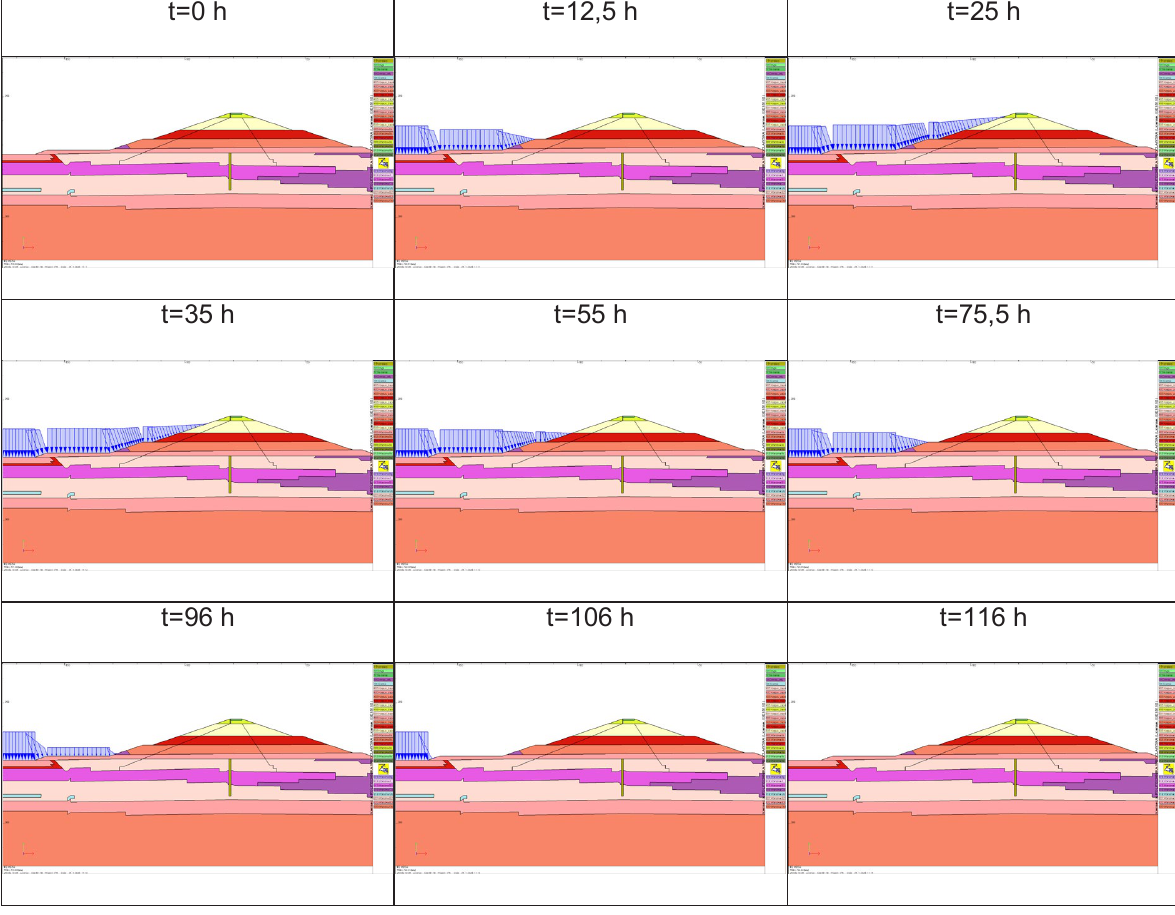
Figure 13: Time-variable boundary condition of water pressure during the passage of the flood wave.